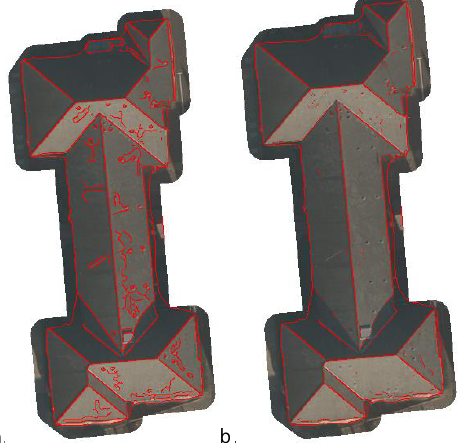
Figure 3. (a) Results of Canny edge detection and (b) the refined edges using scan line segmentation for a complex roof